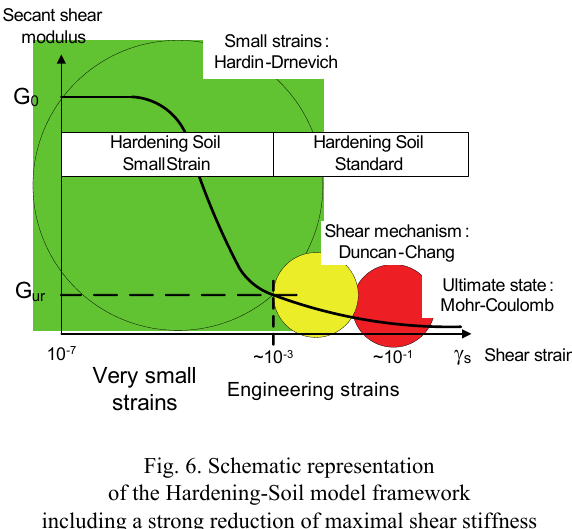
Fig. 6. Schematic representation of the Hardening-Soil model framework including a strong reduction of maximal shear stiffness that occurs with increasing amplitude of shear